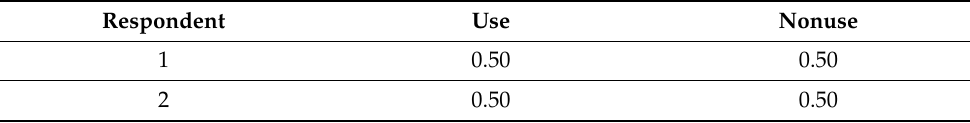
Table A2. Weighted coefficient related to use and nonuse